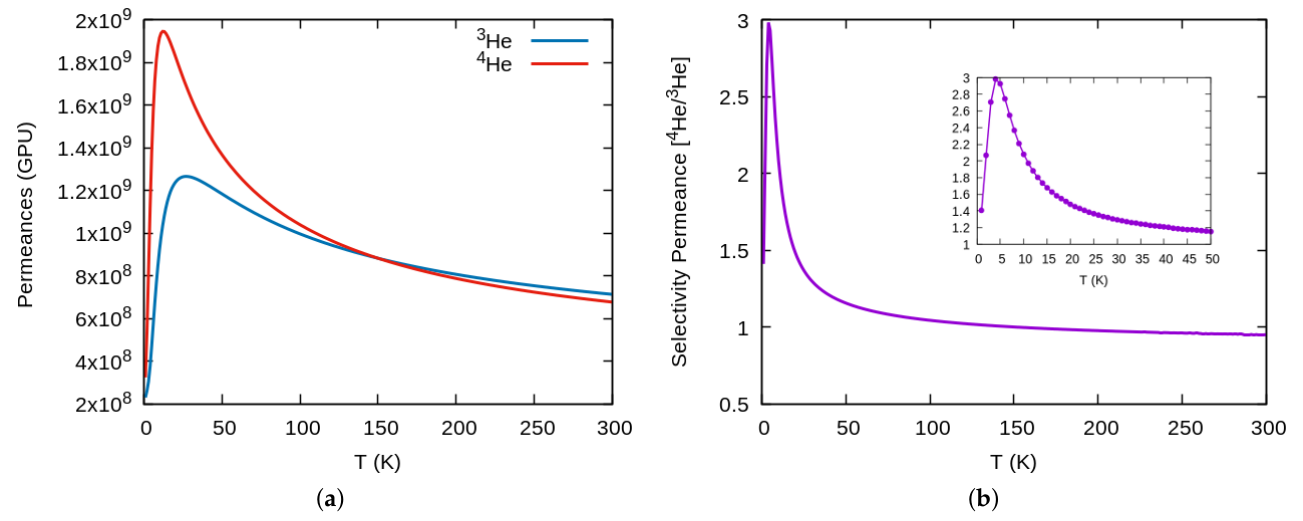
Figure 5. ( a ) Permeances for 3 He and 4 He through graphtriyne at different temperature. ( b ) Permeances selectivity 4 He / 3 He